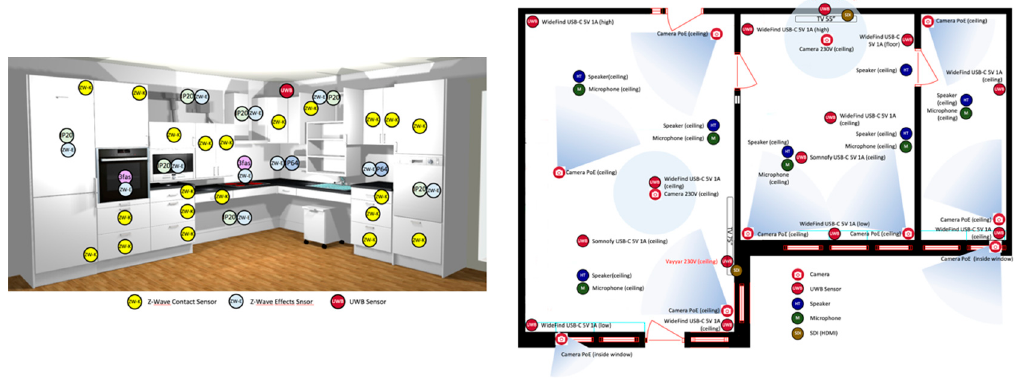
Figure 6. Sensor placement in the H 2 Al: kitchen ( Left ) and apartment ( Right